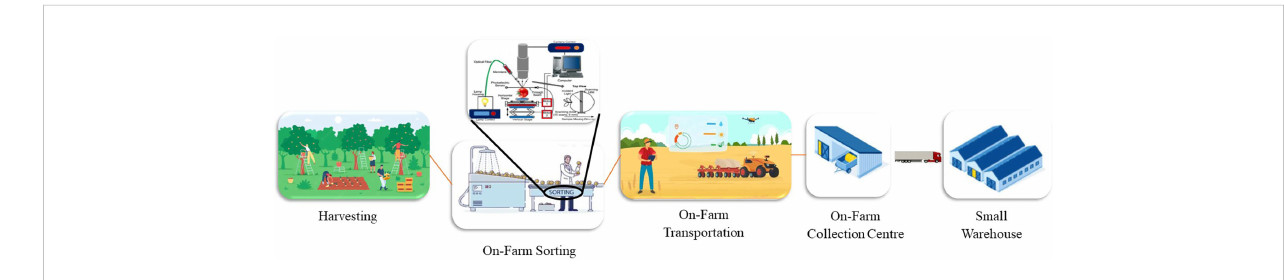
FIGURE 1 Flow diagram of operations involved in on-farm sorting and